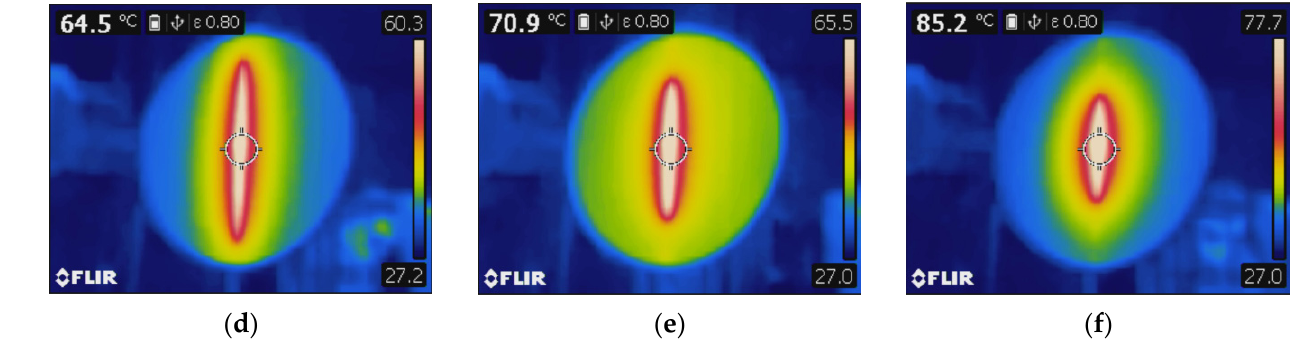
Figure 3. The dipole dimensions at varying propagation distances: ( a ) Infrared image of the diffraction pattern for 57.5 cm for a 39 × 2.9 mm dipole; ( b ) Infrared image of the diffraction pattern for 42.5 cm for a 30 × 2.9 mm dipole; ( c ) Infrared image of the diffraction pattern for 32.5 cm for a 23 × 2.9 mm dipole; ( d ) thermal image with laser for ( a ); ( e ) thermal image with laser for ( b ); ( f ) thermal image with laser for diffraction pattern for 32.5 cm for a 23 × 2.9 mm dipole.